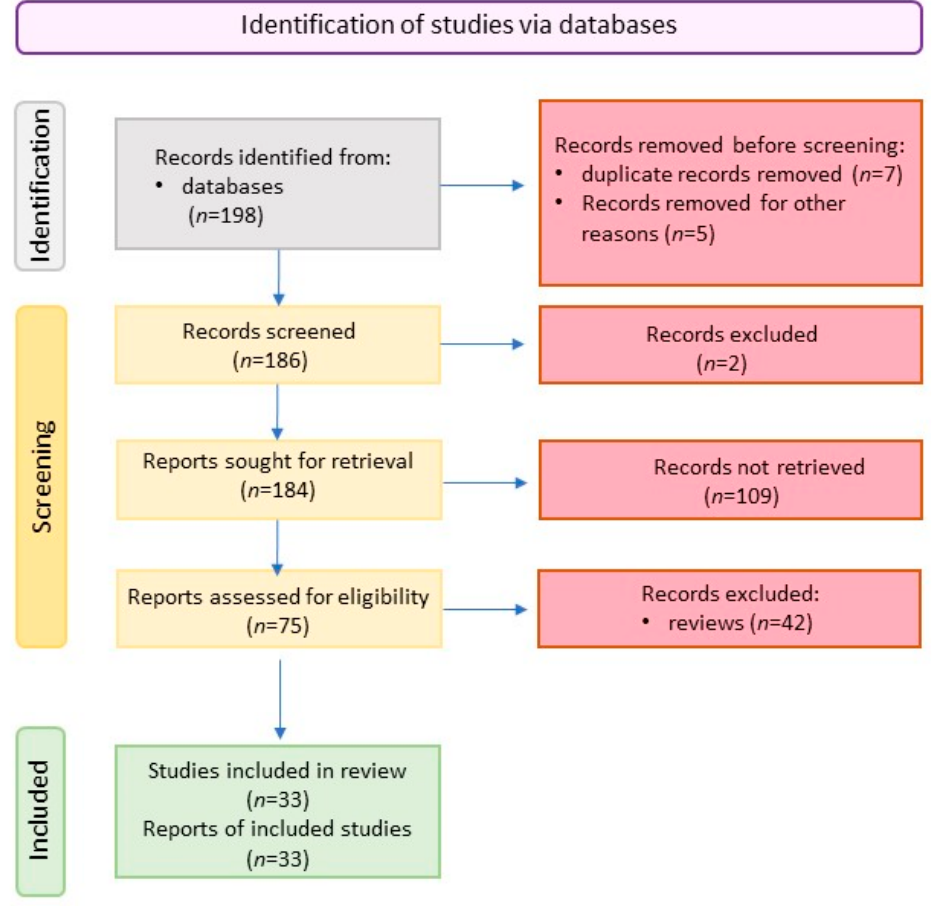
Figure 2. Scheme of literature